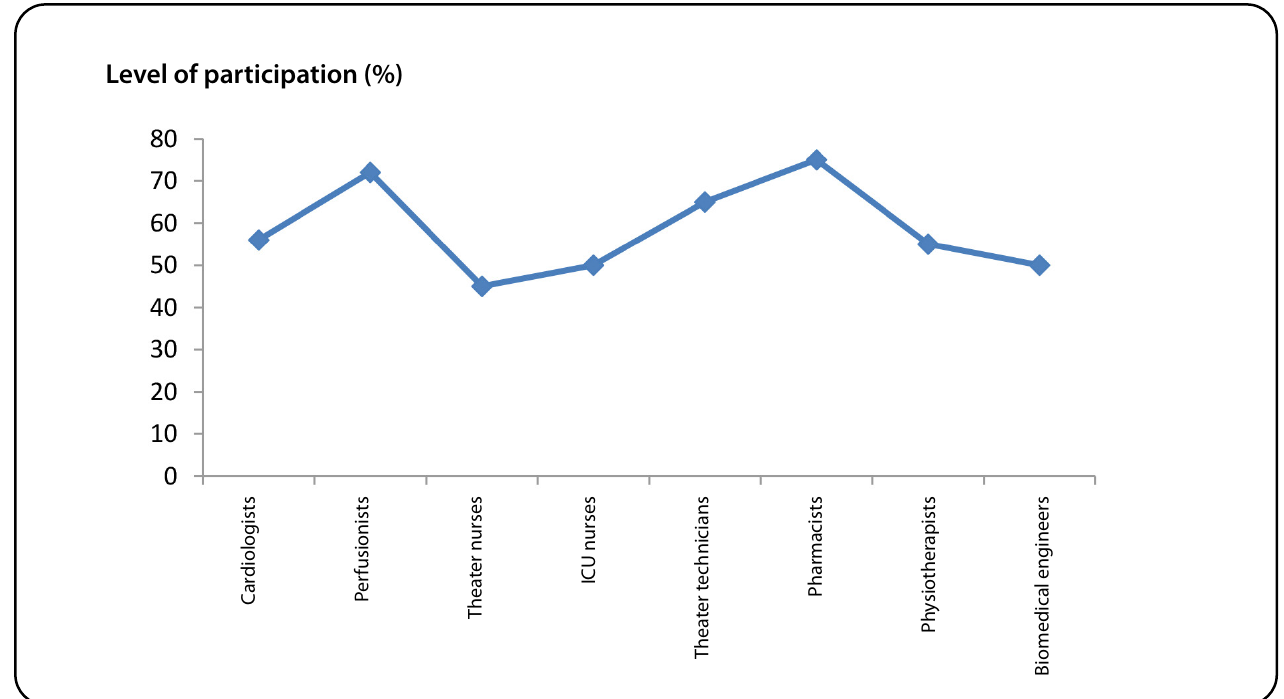
Fig. 3 - Level of participation of other multidisciplinary cardiac team members. ICU=intensive care unit